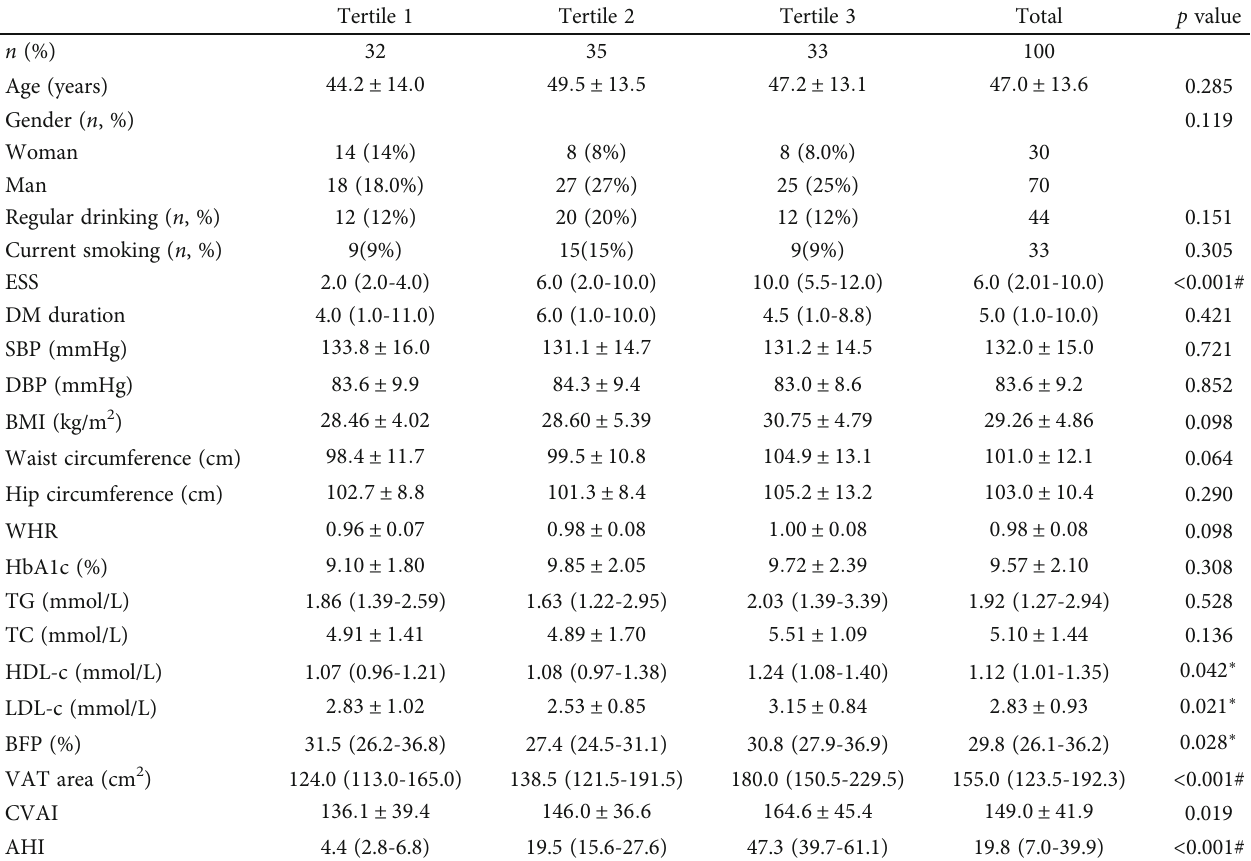
Table 1: Characteristics of subjects by tertiles of AHI in patients with